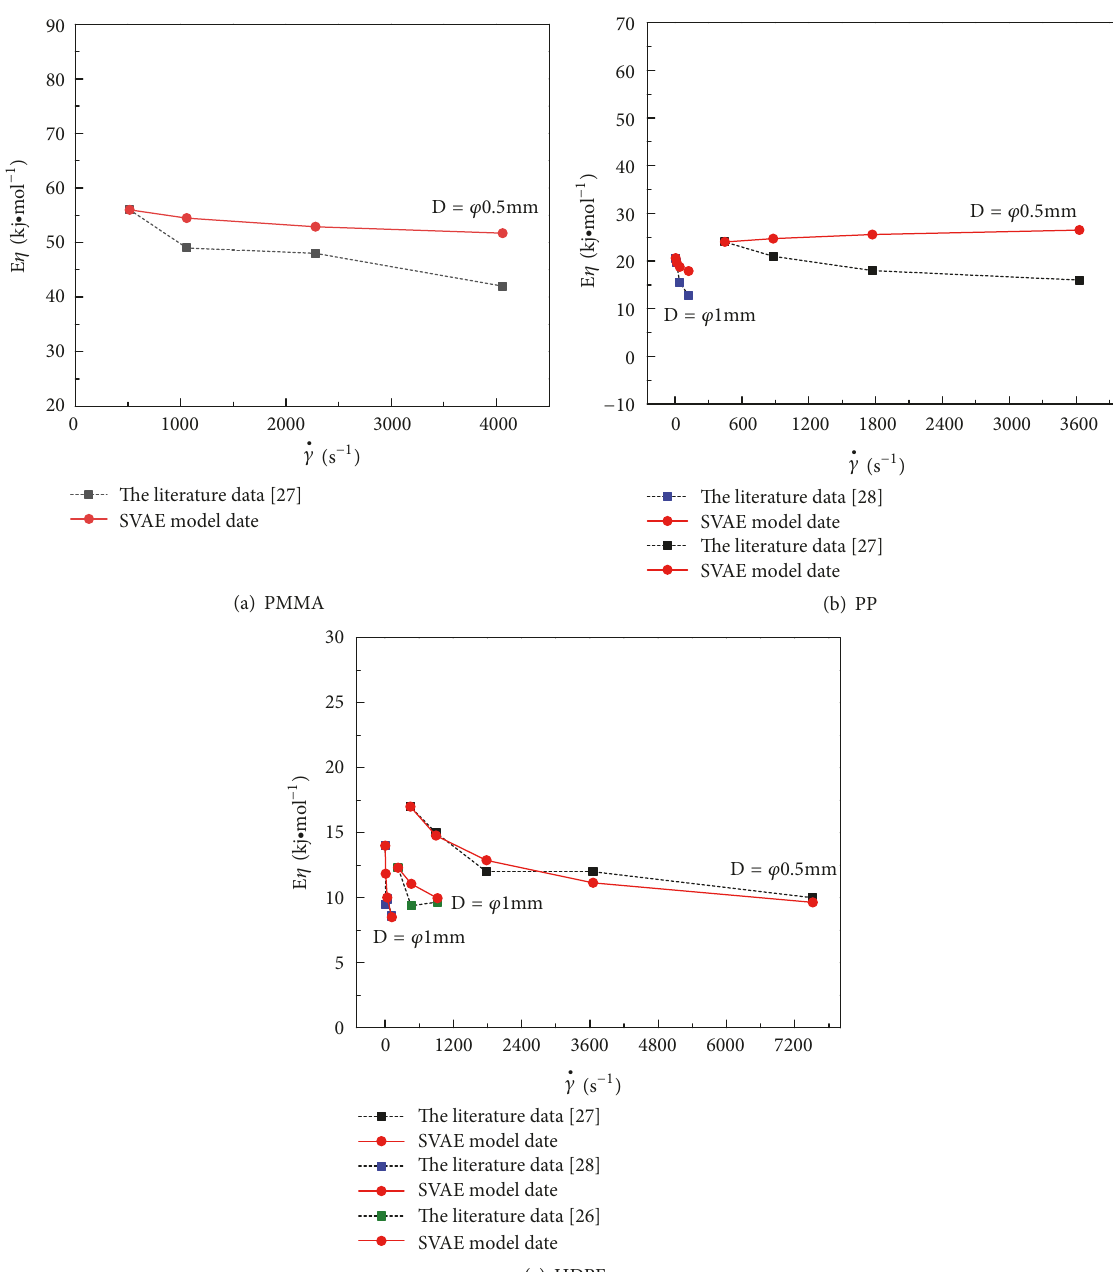
Figure 5: Comparison of viscous flow activation energy between SVAE model and the literature data. (a) PMMA; (b) PP; (c) HDPE.